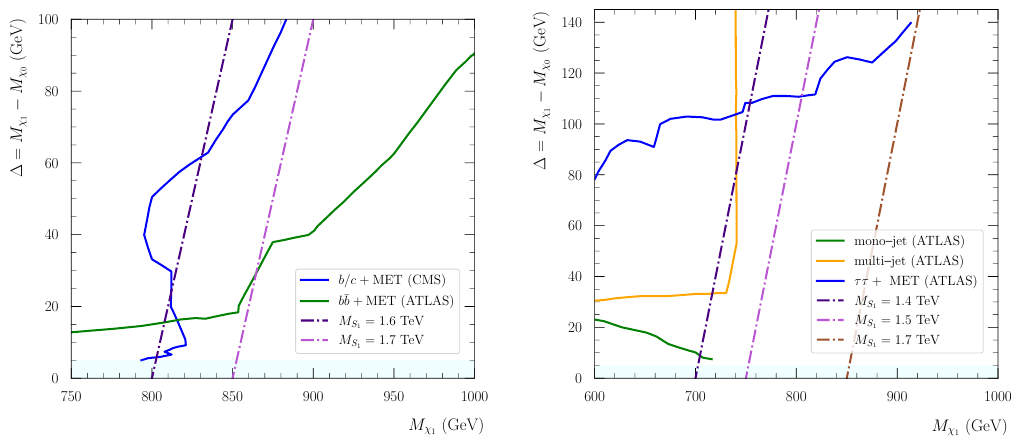
Figure 6 . Collider constraints on our model, presented in the ( M χ panel) and BS2 (right panel) scenarios. We only show exclusions for the studies that are the most constraining ones in a given region of the parameter space, and the dot-dashed isolines correspond to M S = M χ + M χ = 1 . 6 TeV (black) and 1.7 TeV (purple) in the left panel, and to M S 1 1 0 M χ + M χ = 1 . 4 TeV (black), 1.5 TeV (purple) and 1.7 TeV (brown) in the right panel. The 1 0 region with ∆ < 5 GeV is not considered in this study, as χ 1 becomes long-lived and the collider phenomenology is markedly different. In the left panel we show constraints originating from the reinterpretation of the b ¯ b plus MET searches from ATLAS (green) and CMS (blue). In the right panel, we show mono-jet (green), multi-jet plus MET (orange), soft lepton plus MET (red) and τ + τ − + MET (blue)